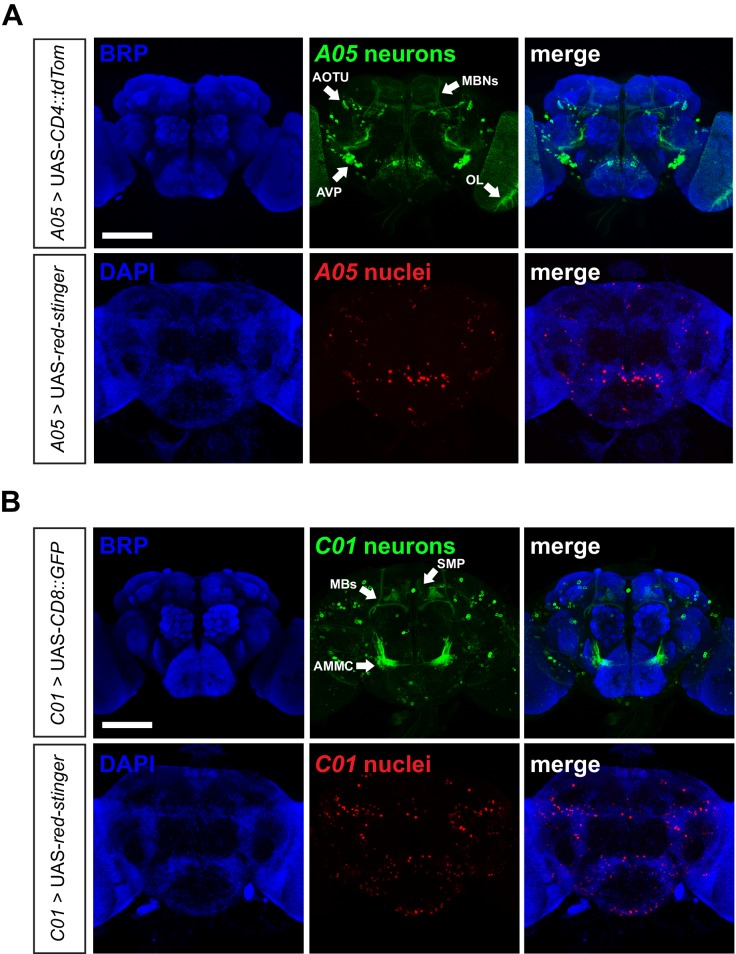
Distribution of A05- and C01-neurons in the adult Drosophila brain.(A–B) Confocal z-stacks of adult male brains expressing genetically-encoded fluorophores labelling either neuronal processes (CD4::TdTom or CD8::GFP) or nuclei (Red-stinger) under the A05- (A) or C01-Gal4 (B) drivers. Neuropil regions are labelled with anti-Bruchpilot (BRP). Nuclei are co-labelled with DAPI. Scale bars, 100 µm. Arrows point to neuropil centers. AOTU: anterior optic tubercle. MBNs: mushroom body neurons. OL: optic lobe. AMMC: antennal mechanosensory and motor center. AVP: anterior ventrolateral protocerebrum. SMP: superior medial protocerebrum.10.7554/eLife.38114.023Figure 5—source data 1.Sleep levels following Nca knockdown in C01-, A05- or ok107-neurons (or combinations of), relating to Figure 5—figure supplements 1 and 2.Blank cells represent data from dead flies removed prior to analysis.